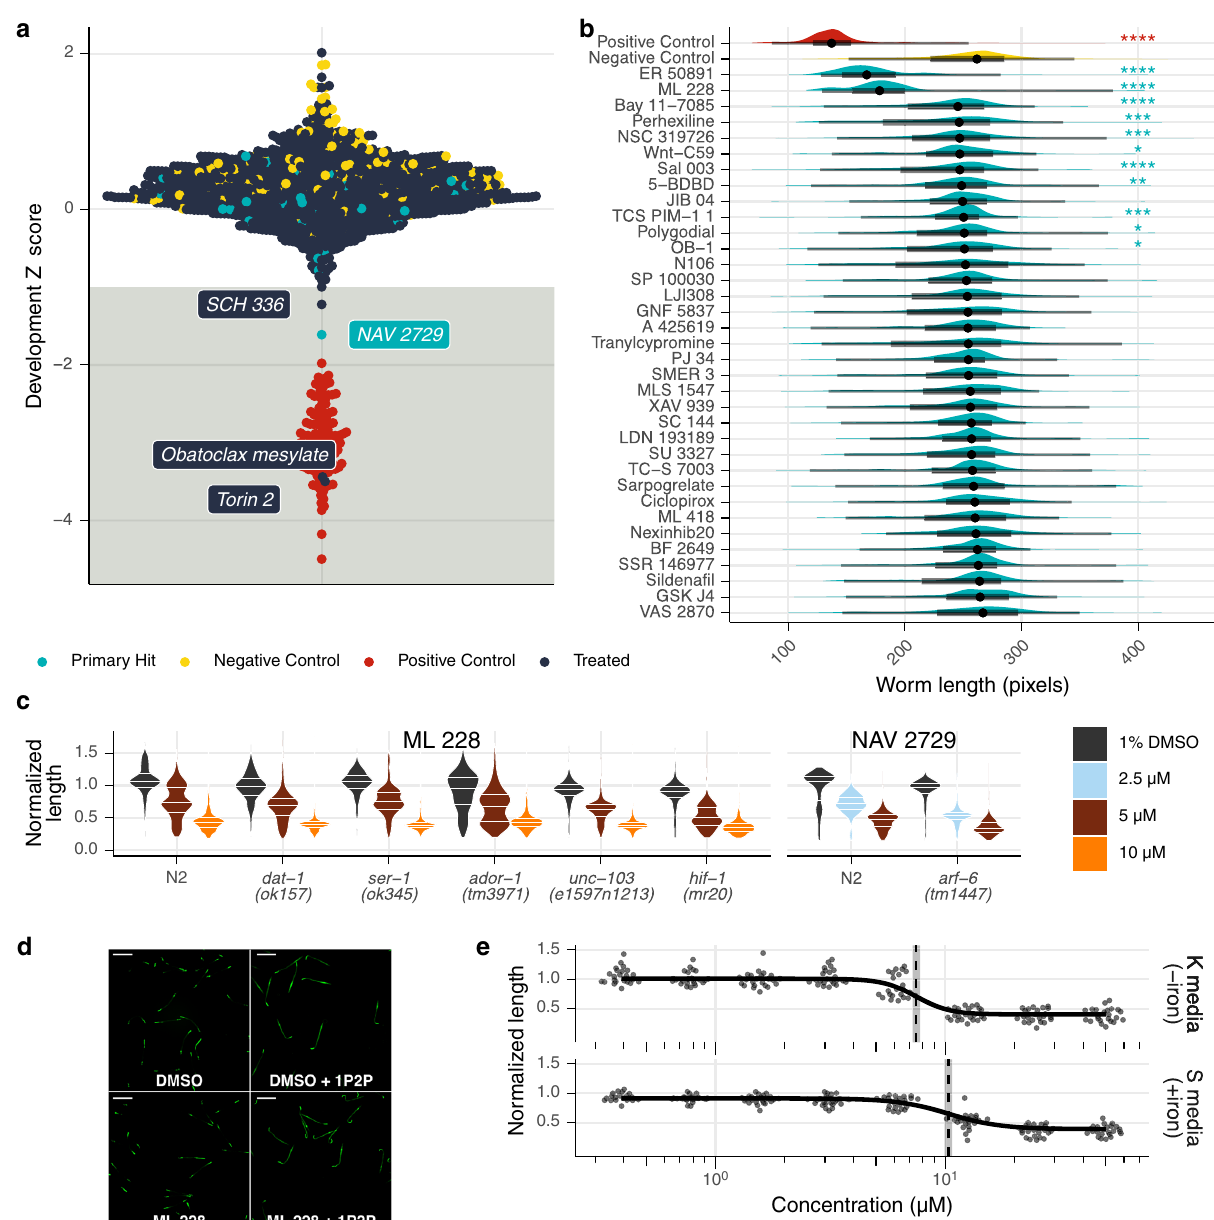
Fig. 4 A development screen of a free-living model nematode. a C. elegans development screen of entire Tocriscreen 2.0 compound library at 1 µ M. Light blue hits are shared in B. malayi mf (see Fig. 2). b Follow-up 10 µ M screen of hits in B. malayi mf that were not hits in C. elegans at 1 µ M. Positive control is 50 mM albendazole sulfoxide. Asterisks indicate signi fi cance (**** p < 0.0001, *** p < 0.001, ** p < 0.01, * p < 0.05; Dunn ’ s test). c C. elegans development assay with selected knock-out strains. Data are normalized to the median length of the DMSO-treated worms. d Hypoxia activation after treatment with 50 µ M ML 228 or 1.25% 1P2P. Scale bars represent 500 µ m. e ML 228 dose-response of C. elegans development when grown in K or S